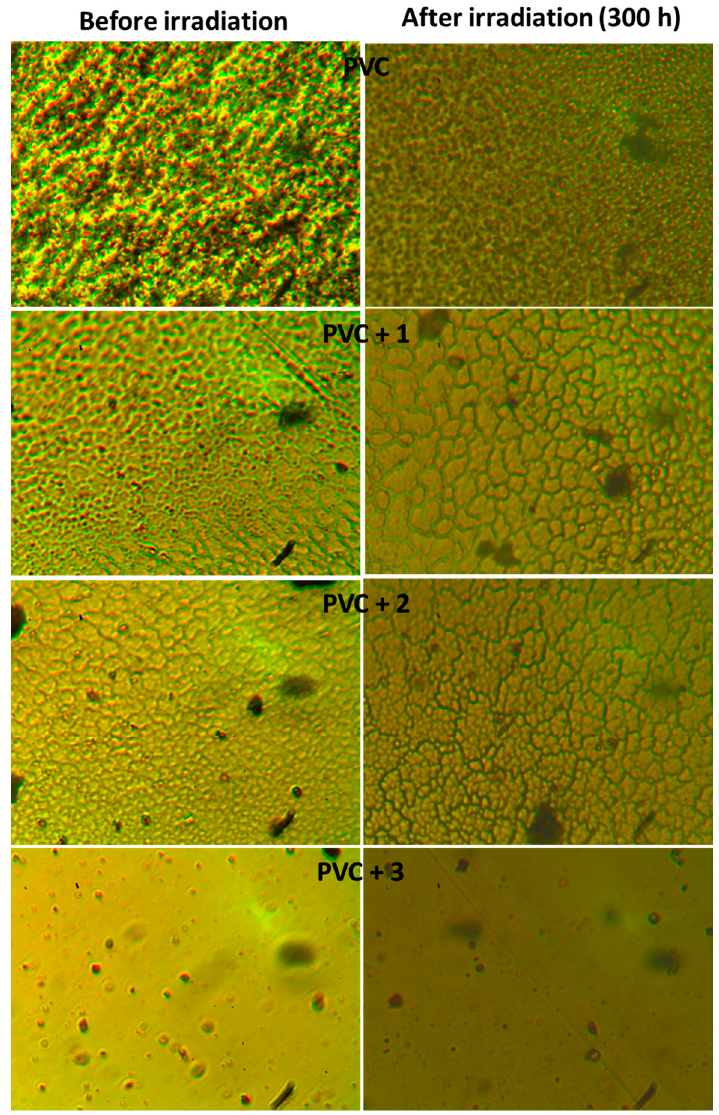
Figure 10. Effect of irradiation of PVC films on surface morphology.